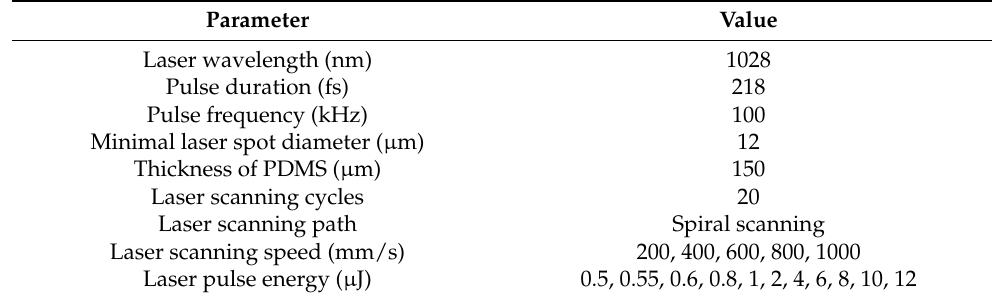
Figure 4. Schematic diagram of the femtosecond laser spiral scanning path.